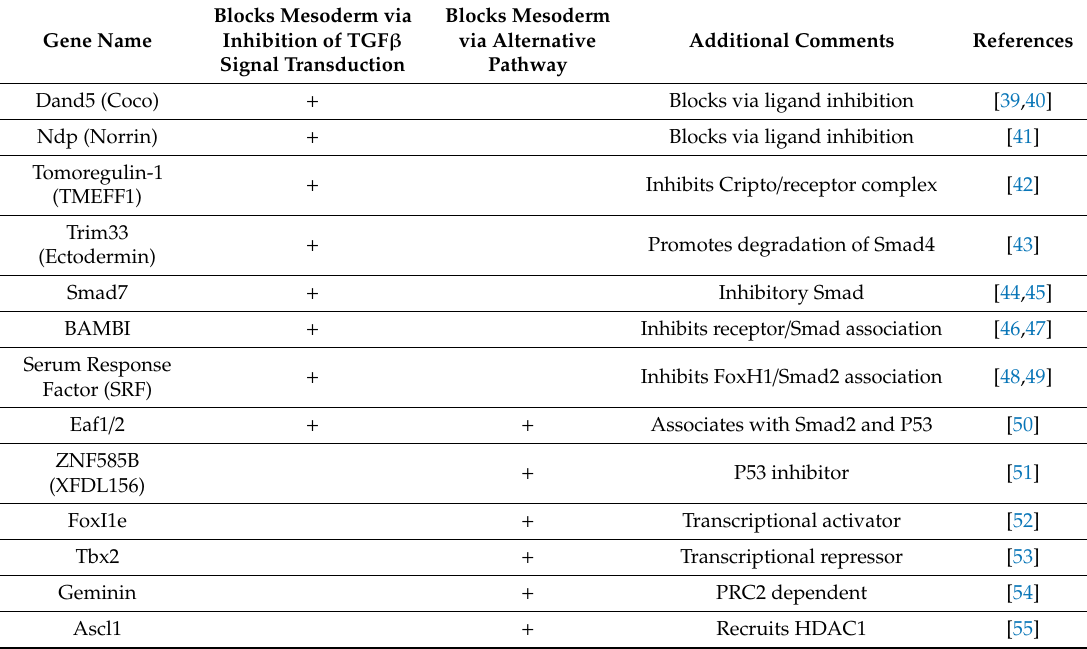
Table 1. Inhibitors of mesoderm in Xenopus laevis